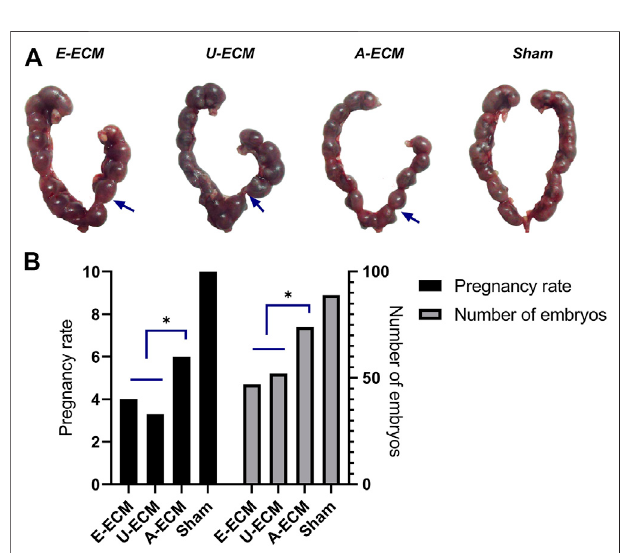
FIGURE 6 | Evaluation of proliferative cells and vascular regeneration in the endometrium. At postoperative week 4, (A) Ki-67 and CD31 immunohistochemistry staining were used to compare cell proliferation and vascularendothelialcellregenerationintheendometrium,andthevalues were quantitated (B) for all the groups.* p < 0.05 and ** p < 0.01, one-way ANOVA with Tukey ’ s post hoc test. Bar = 50 μ m.